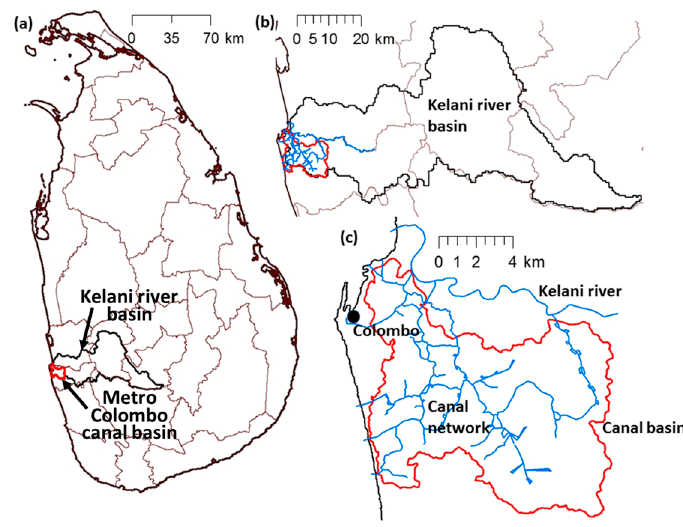
Figure 1. Study area: ( a ) Administrative districts of Sri Lanka; location of the Kelani River basin and the Metro Colombo canal basin; ( b ) Kelani River basin and the location of Metro Colombo canal basin and the canal system; ( c ) Metro Colombo canal system.